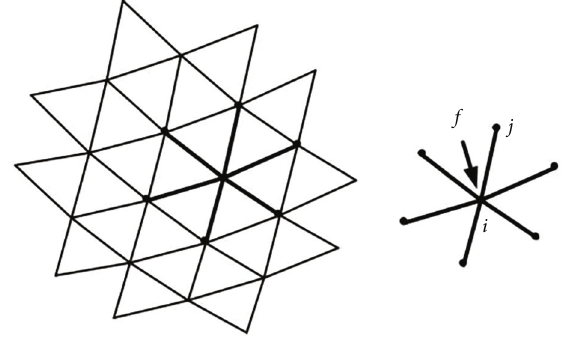
Figure 3: The force density method